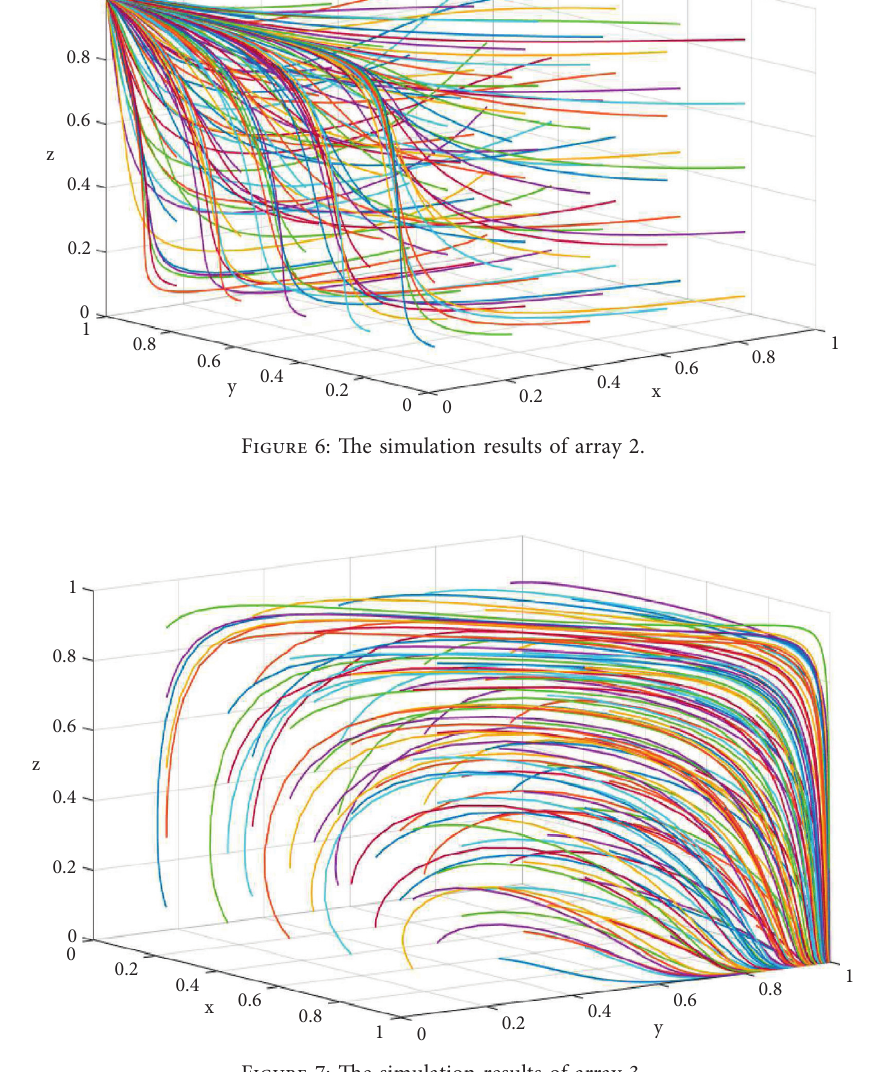
Figure 7: The simulation results of array